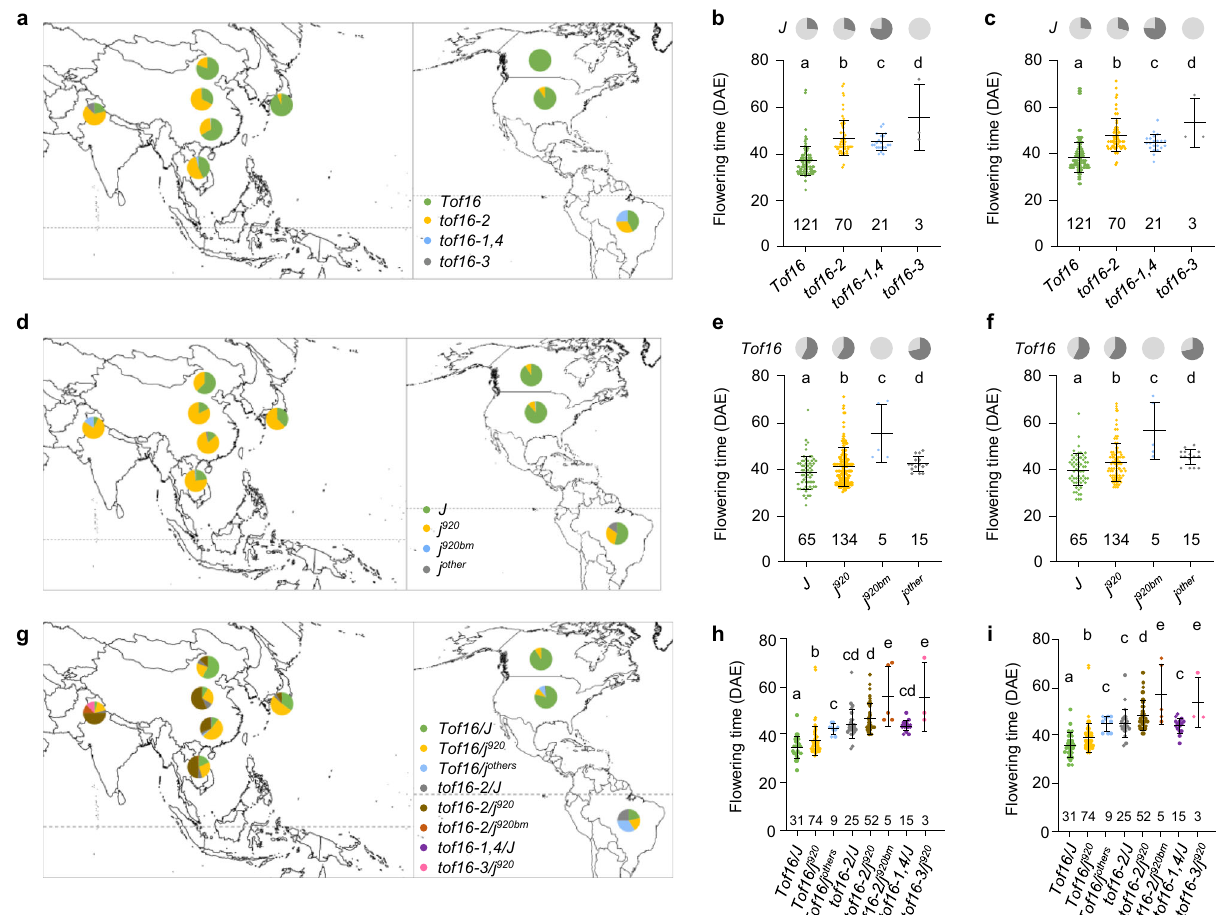
Fig. 4 Geographical distribution of genetic diversity of Tof16 and J . a Loss-of-function alleles of Tof16 frequency is highly correlated with low latitude regions. Data from 1624 diversity panels. b – c Flowering time(R1) variations in 329 accessions possess Tof16 and tof16 alleles in Guangzhou 2018 ( b ), and Guangzhou 2019 ( c ). Proportions of j alleles in upper pie chart. Dark gray represents J alleles and light gray represents j alleles. d Loss-of-function alleles of J frequency is highly correlated with low latitude regions. Data from 1624 diversity panels. j 920 represents j-11 allele including J-SNP G920T . j 920bm represents SNP920-based mutations including j-1, j-3 , j-6 and j-10 mutational alleles. j-others represents j mutations other than j 920bm . e – f Flowering time(R1) variations in 329 accessions possess J and j alleles in Guangzhou 2018 ( e ), and Guangzhou 2019 ( f ). Proportions of tof16 alleles in upper pie chart. Dark gray represents Tof16 alleles and light gray represents tof16 alleles. g Loss-of-function Tof16 and J improve soybean adaptation to low latitudes. Data from 1624 diversity panels. h – i Flowering time variations of eight allelic combinations of Tof16 and J in Guangzhou 2018 ( h ), and Guangzhou 2019 ( i ). The presence of the same lowercase letter above the histogram bars in ( b , c , e , f , h , i ) denotes nonsigni fi cant differences across the two panels ( P > 0.05). One- way ANOVA was used to generate the P values. All data were given as mean ± s.e.m. The value of each plant was represented by a dot. Source data underlying Fig. 4b, c, e, f, h, and i are provided as a Source Data fi